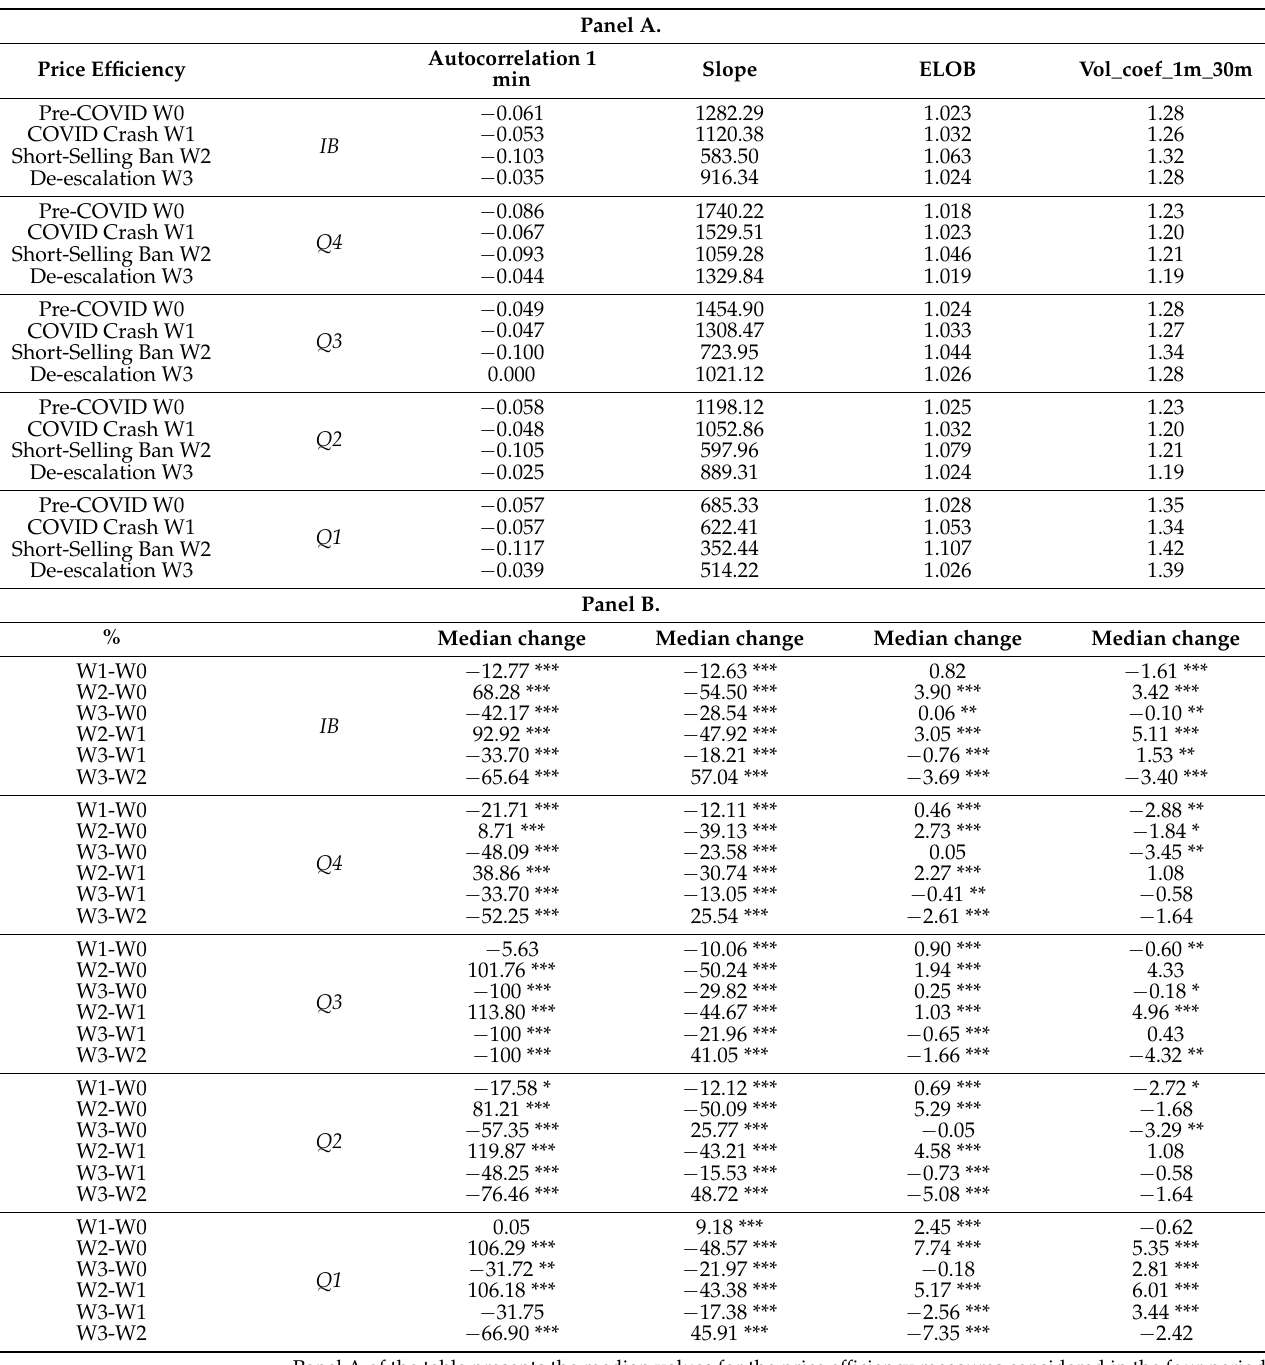
Table 5. Panel A. Price efficiency measures. Panel B. Change in median: price efficiency measures. Panel A.